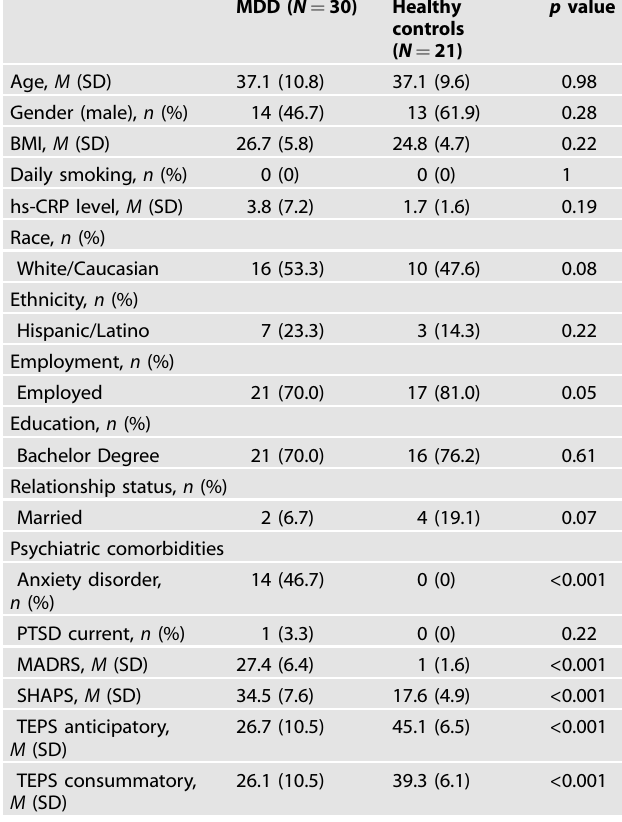
Table 1. Demographic and clinic characteristic of study